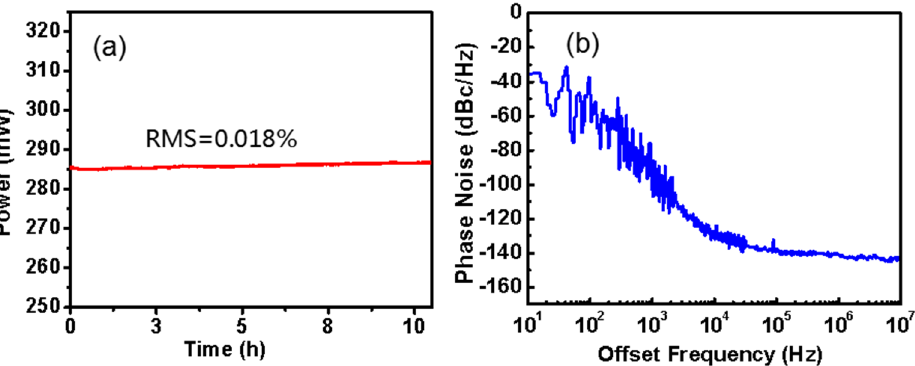
Figure 4. ( a ) Power fluctuation and ( b ) Phase noise characteristics of the ~1 GHz “solid-state fiber laser” with 1.5 W for the injected pump power and − 3000 fs 2 for net cavity dispersion.